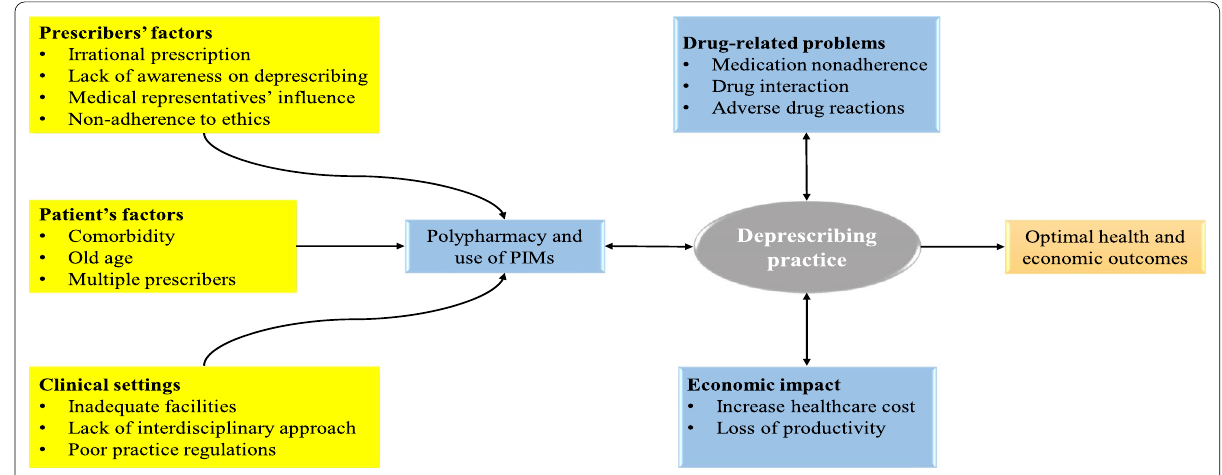
Fig. 1 Overview of deprescription practice in